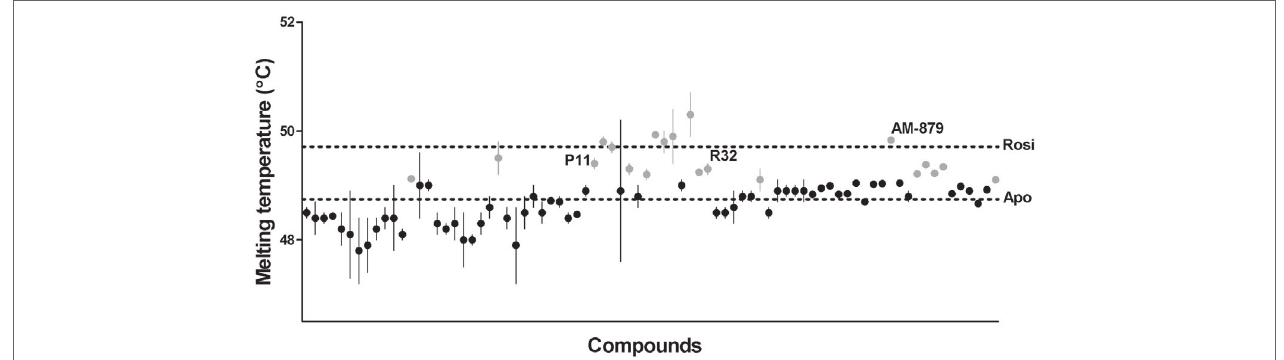
FigUre 1 | Melting temperature of peroxisome proliferator-activated receptor gamma (PPAR γ ) obtained by thermal shift assay (TSA) in the presence of 80 screened compounds. Upper dashed line marks the melting temperature (Tm) of PPAR γ in presence of Rosiglitazone (Rosi; positive control) and the lower dashed line marks the Tm of apo-PPAR γ (negative control). Gray circles represent the 20 selected compounds with highest Tm, and the black circles correspond to the unselected compounds. Tm of the three ligands selected at the end of screening are indicated by their names P11, R32, and AM-879. thermal shift assay was performed in triplicates in three independent experiments, errors bars represent